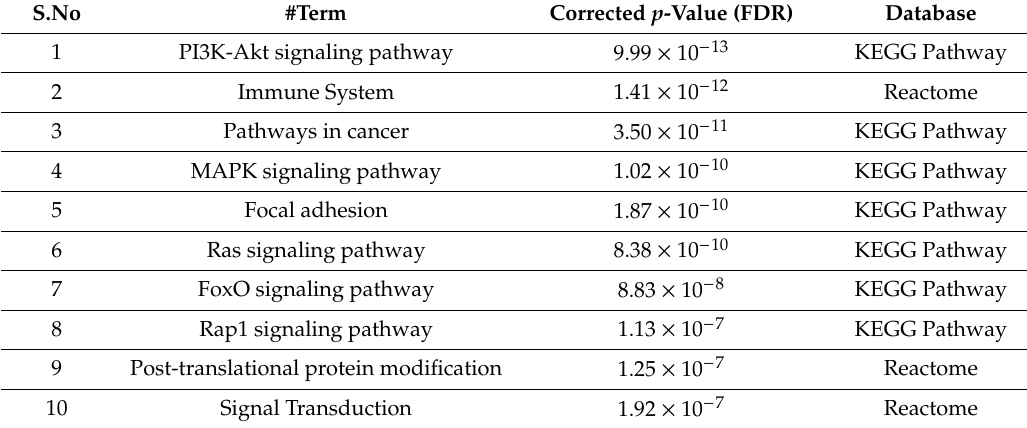
Table 3. List of the top 10 enriched pathways with corrected p -values and corresponding databases, identified using target genes of upregulated miRNAs at 4 h following systemic ovine LPS challenge.